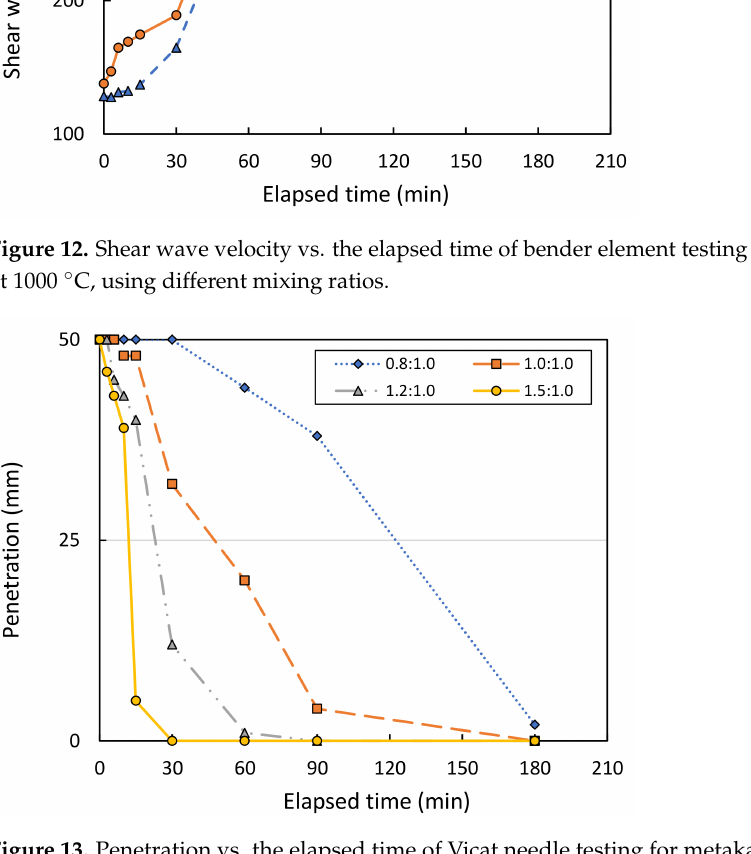
Figure 13. Penetration vs. the elapsed time of Vicat needle testing for metakaolin treated at 800 ◦ C, using different mixing